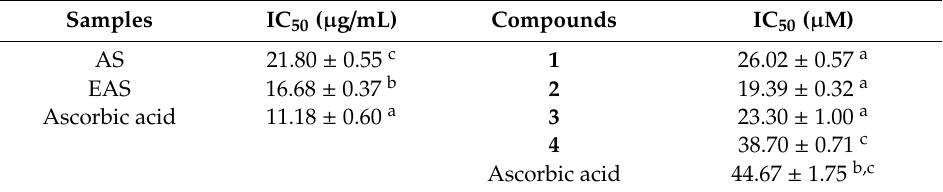
Table 1. IC 50 values of Alnus sibirica (AS), enzymatic hydrolysis (EAS), and the isolated compounds